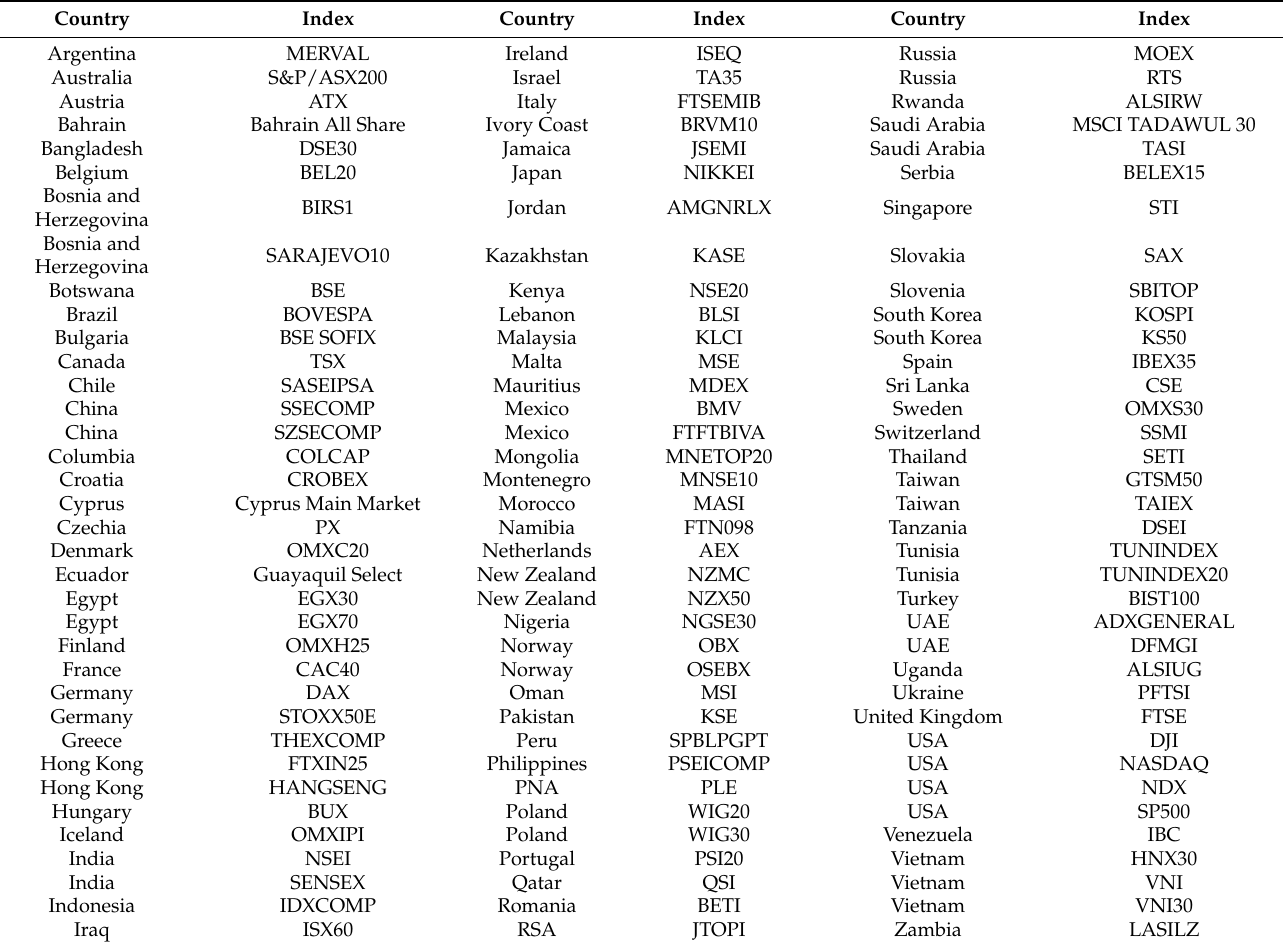
Table A1. Stock indices used in the study. Source: own